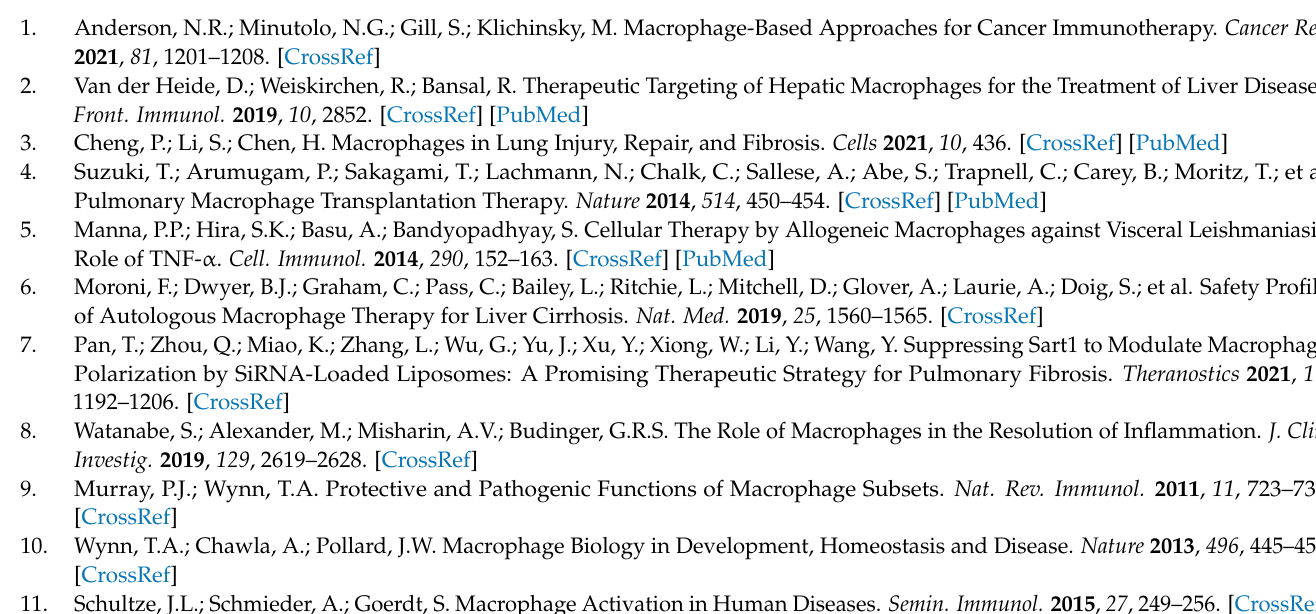
Table S1: Primer Sequence used for qPCR; Table S2: siRNA sequences for targets